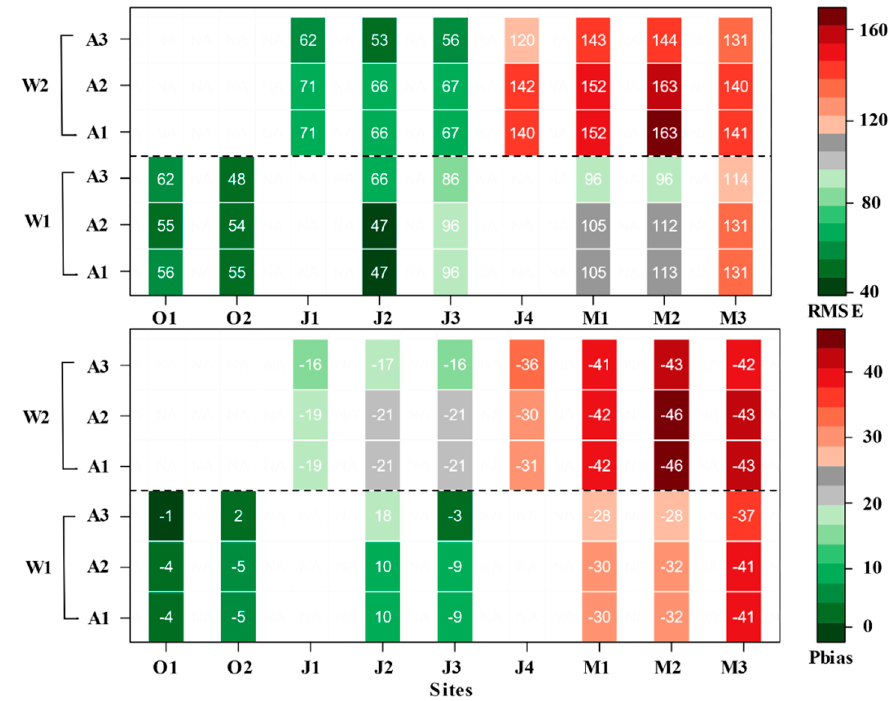
Figure 4. Performance of algorithms A1 to A3 in terms of the RMSE (mm w.e.) and Pbias (%). The colours of the bars denote absolute values.